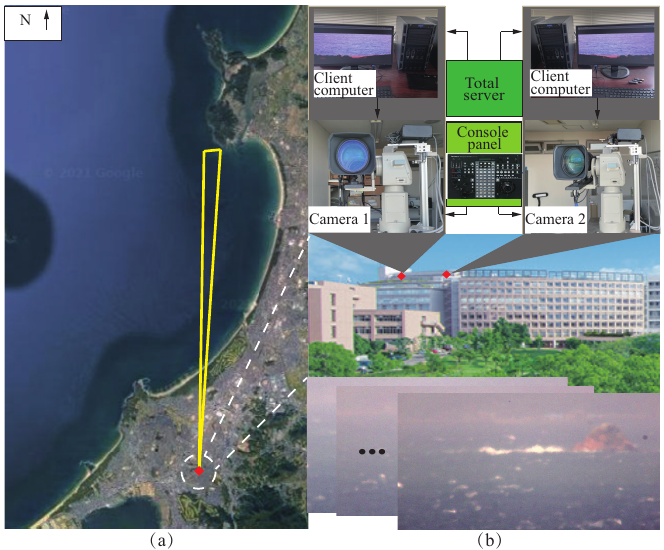
Figure 11. Experiment deployment of the proposed system: ( a ) the monitoring area and ( b ) actual components and